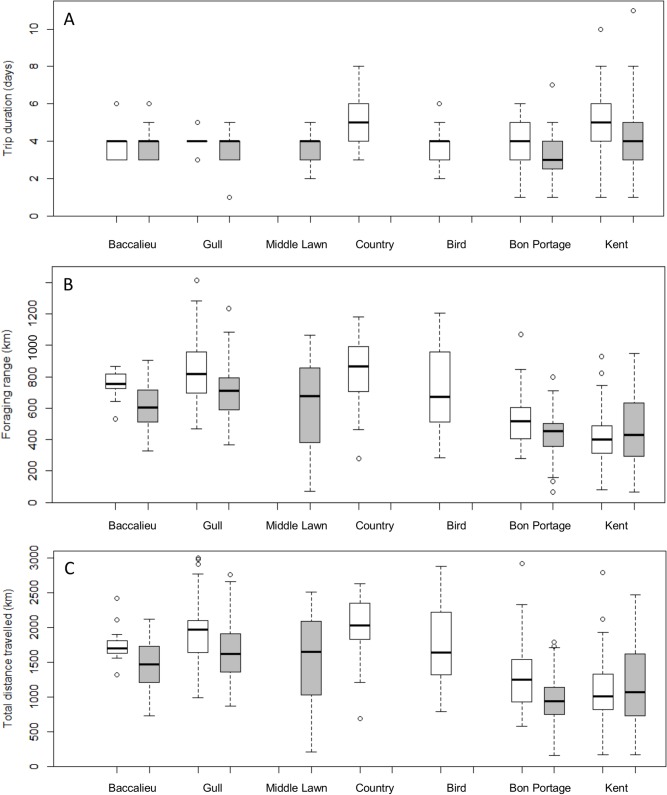
Incubation foraging trip characteristics.(A) Trip duration, (B) foraging range, and (C) total distance travelled by Leach’s storm-petrels in 2013 (white) and 2014 (grey). Box plots show the median and 25th and 75th percentiles, whiskers indicate values within 1.5 times the interquartile range, and circles represent outliers.